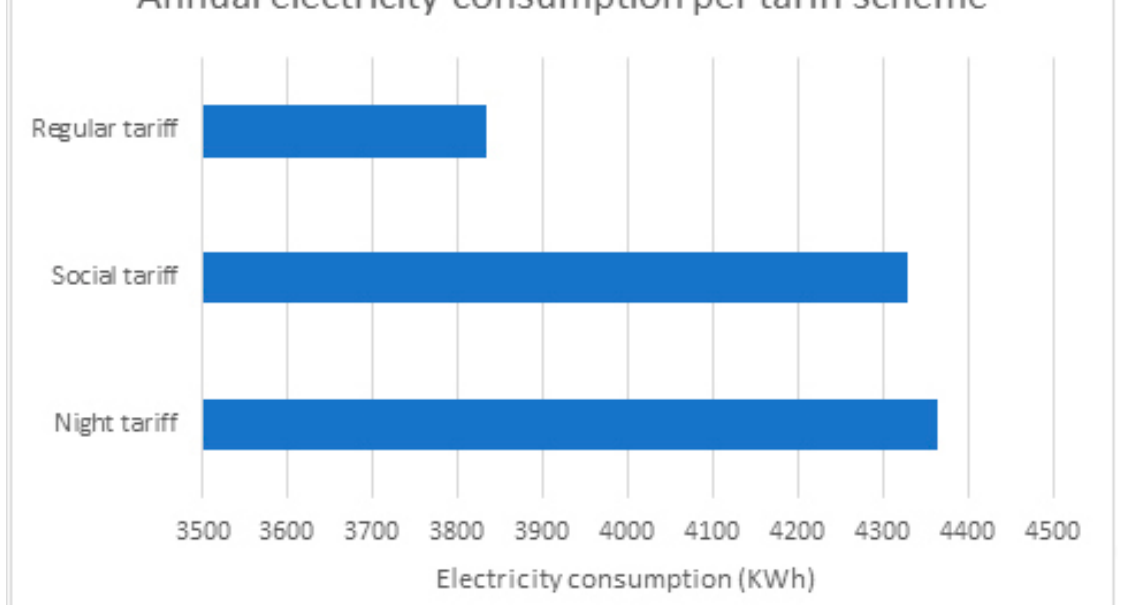
Figure 9. Average annual electricity consumption by tariff